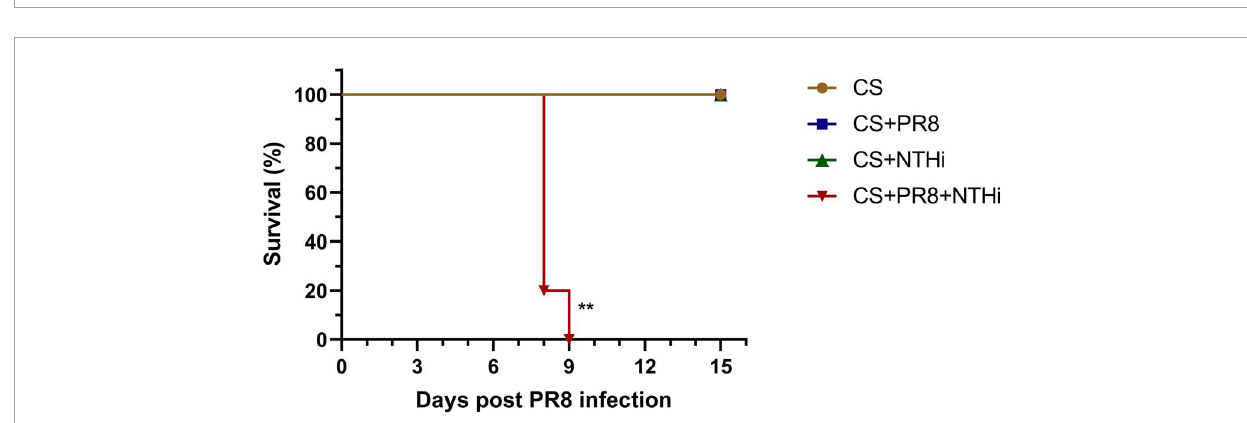
FIGURE3 Lethal synergistic effect of PR8-NTHi coinfection in COPD mice. Three days following intranasal infection with 1 LD 50 of PR8, COPD mice were challenged with 10 5 CFU of NTHi. Survival ( n = 5) was recorded for 15 days. ** p < 0.01 compared with CS-exposed group.